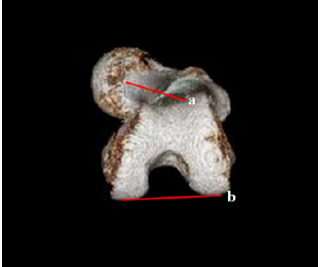
Figure 8. Femoral anteversion angle between a and b using the D line in the 3D reconstruction section of the caudal to cranial 3D reconstruction view: (a) the connecting line between the center of the femoral head and the mid-portion of the neck; (b) the connecting line between the posterior border of both femoral condyles.